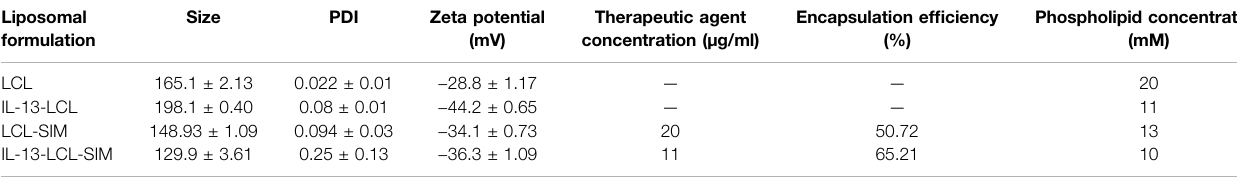
PDI, polydispersity index. Data are presented as mean ± SD of three independent measurements.